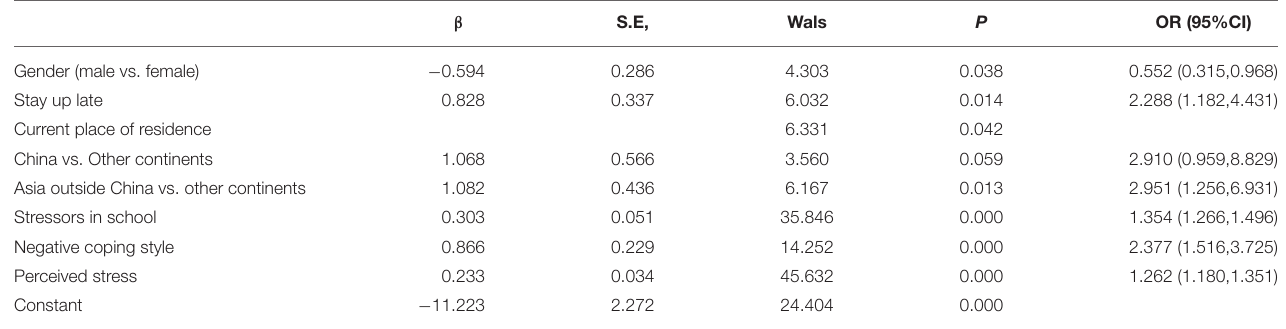
TABLE 5 | Stepwise multiple logistic regression analysis on results of depressive symptoms ( n = 519). β S.E, Wals P Gender (male vs.